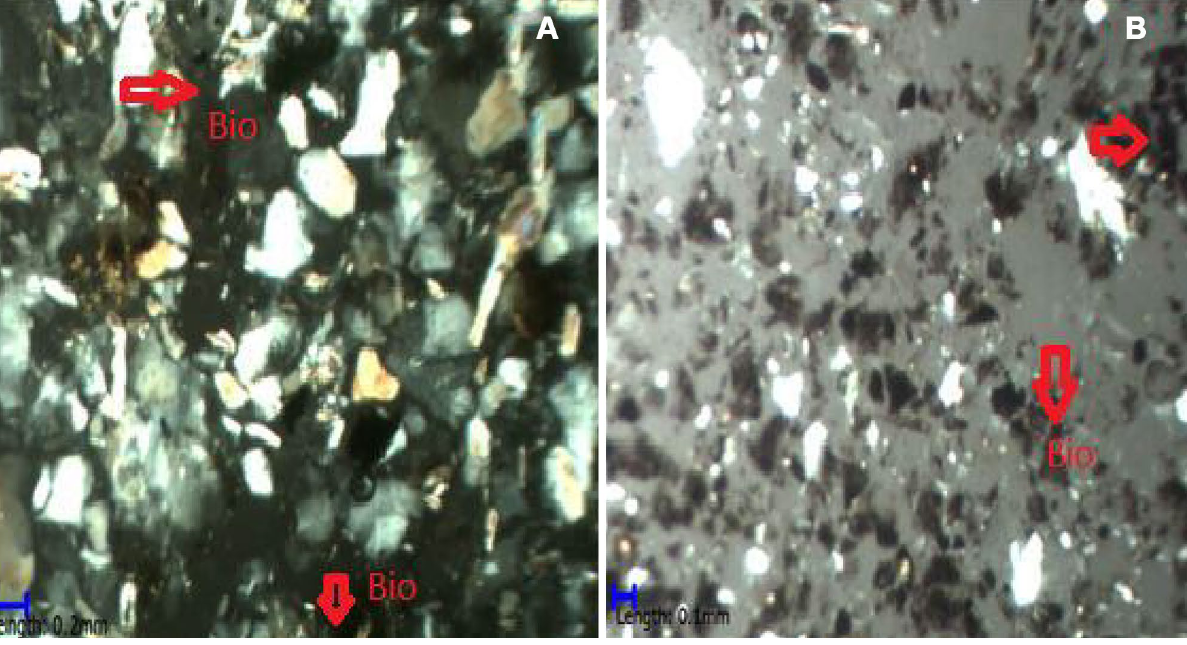
Fig. 12 a, b Biotite in Araromi-Obu/Ago-Alaye at depth 81–84 m under plane polarised light (PPL) and at Ajegunle A4 at depth 54–57 m under plane polarised light